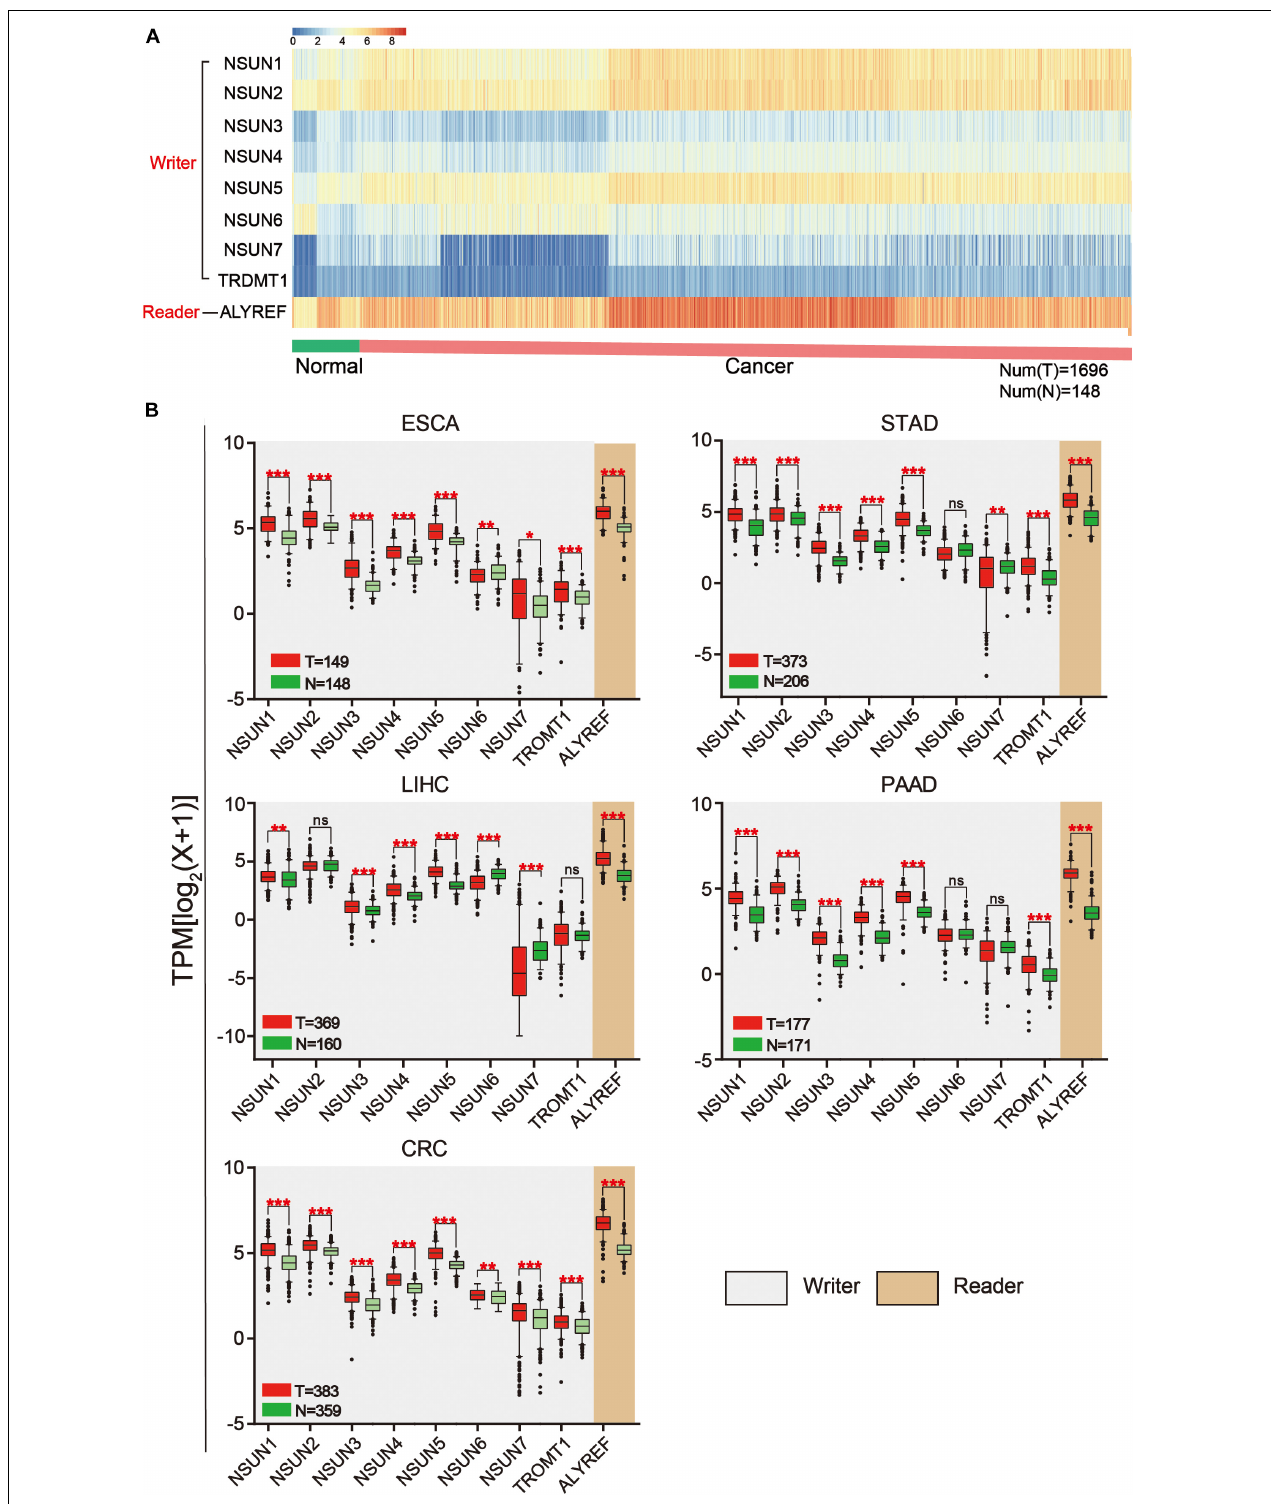
FIGURE 2 | Expression of m 5 C writers and reader in GI cancer. (A) Based on RNA sequencing data from the TCGA database, a heat map of m 5 C writer and reader expression was drawn. Data were collected from cancer patients ( n = 1,568) and healthy patients ( n = 139). Each sample was normalized and was represented by a square. Red and blue regions represented higher and lower expression levels, respectively. (B) RNA sequencing data were used to compare the expression level of each m 5 C regulator between tumor and normal samples in different GI cancer types.